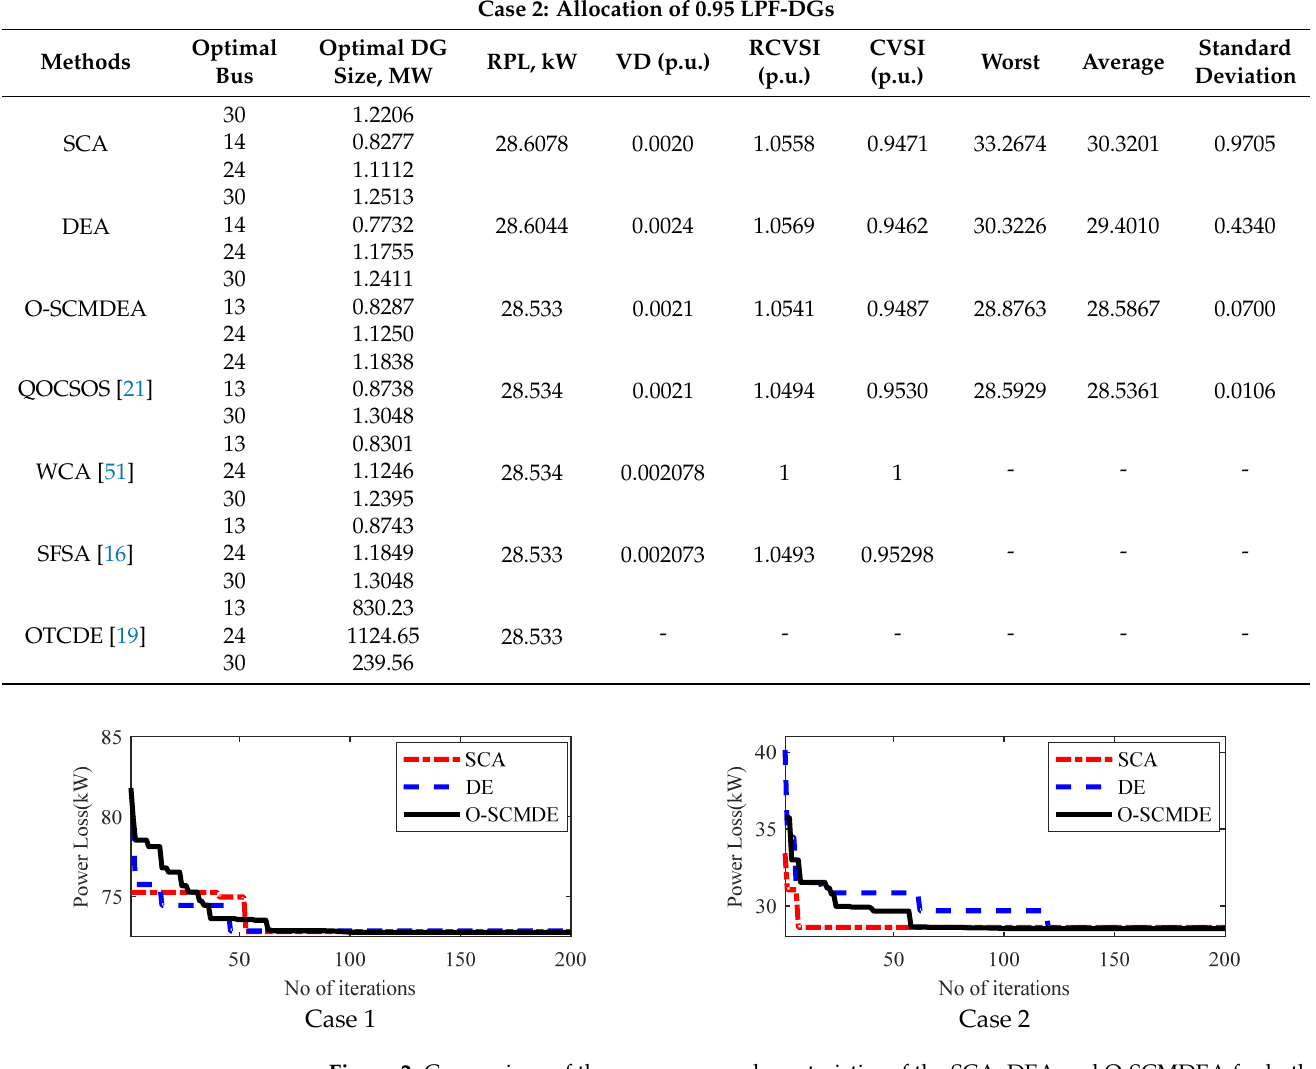
Figure 2. Comparison of the convergence characteristics of the SCA, DEA and O-SCMDEA for both cases of scenario I of the 33 bus system.